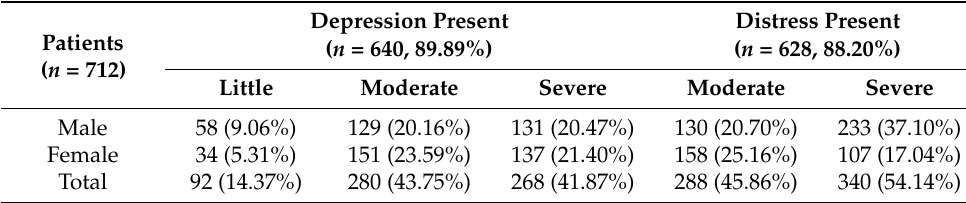
Table 3. Presence measures of diabetes distress and depression in the study population.